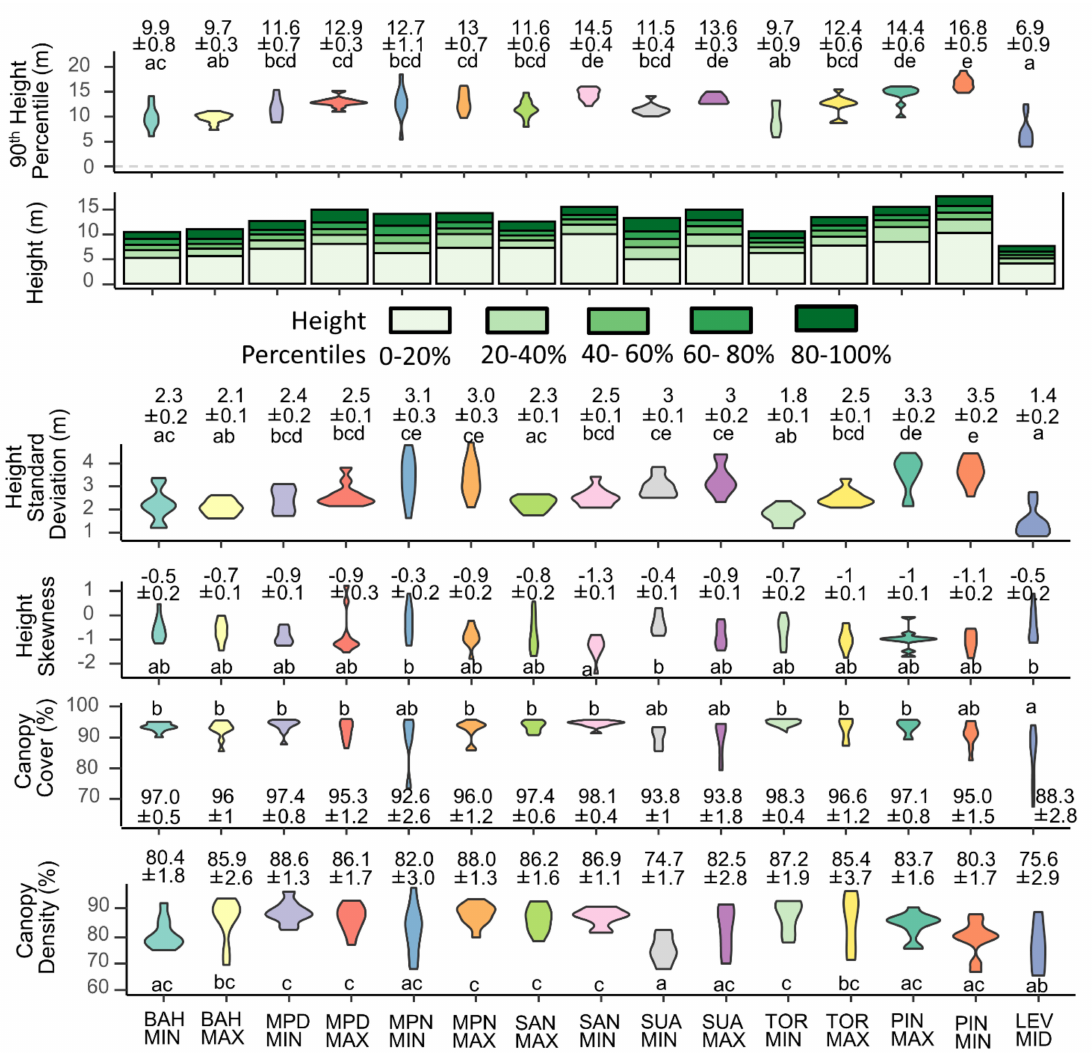
Figure 3. Forest structure based on LiDAR measurements. Violin plots show the distribution density of each variable, with wider portions representing higher density. Annotations are means and standard errors, and di ff erent letters denote statistical di ff erences. Violins are colored by site, while bar plots of heights are colored to show the distribution of height by